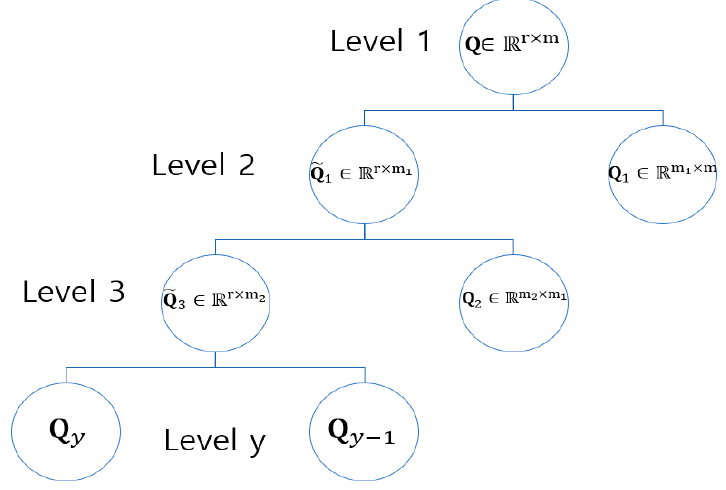
Figure 6. Generating customer’s implicit dormant features.